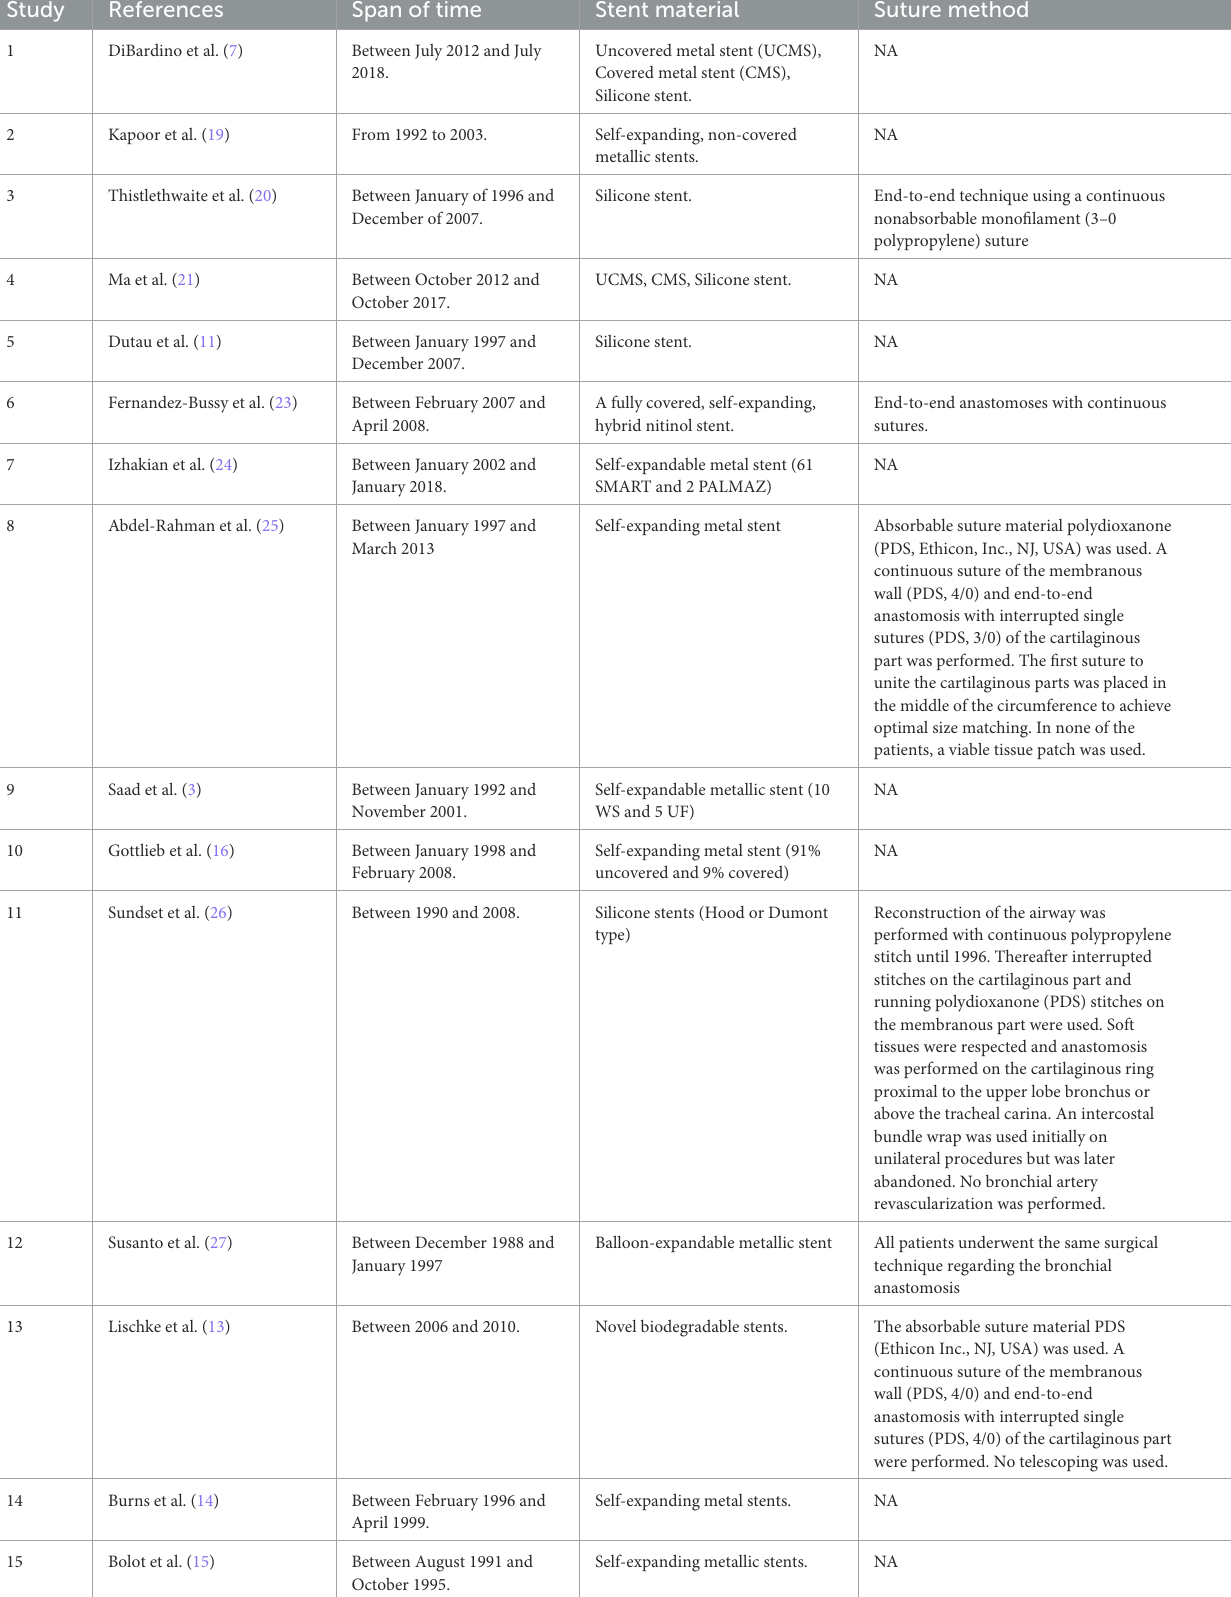
TABLE 1 Characteristics of